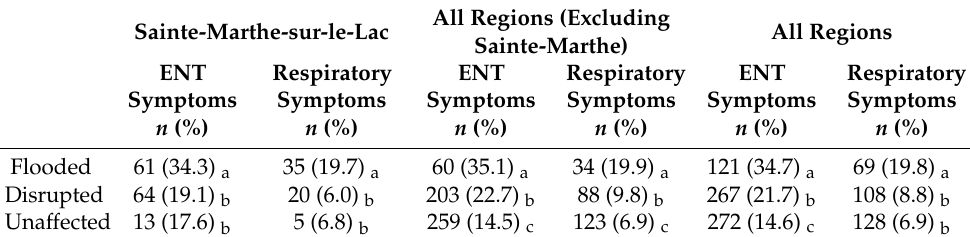
Table 3. Respiratory health according to flood exposure and